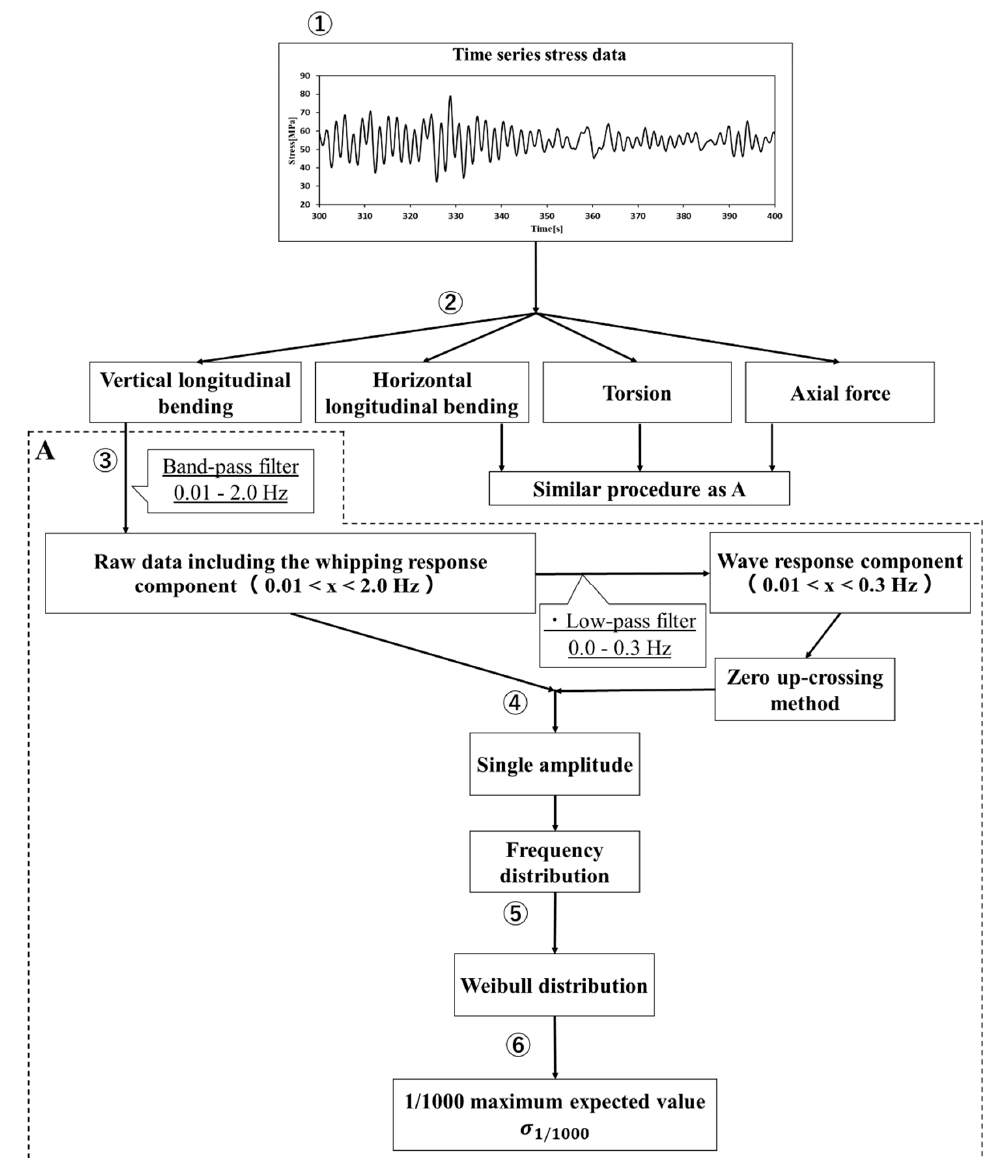
Figure 2. Data analysis flowchart.